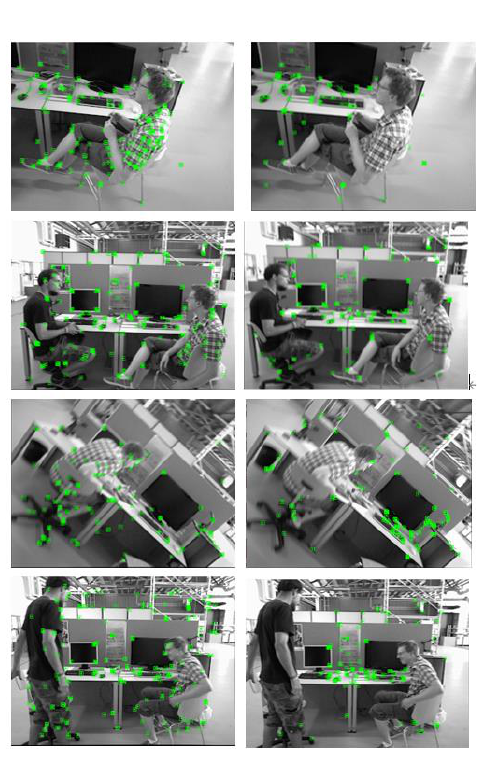
Figure 3. Feature extraction of ORB SLAM2 and our